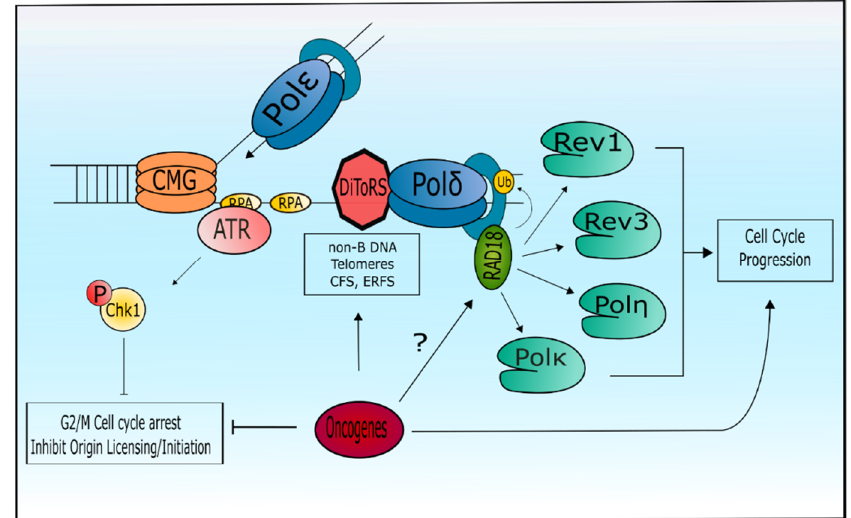
Figure 3. Conceptual framework for the role of specialized polymerases in oncogene induced replication stress. Oncogene activation promotes DNA replication thereby increasing replication fork encounters with DiToRS. Fork stalling activates the ATR/Chk1 axis and the subsequent recruitment of specialized DNA polymerase to resolve impediments. Rad18-mediated ubiquitination of PCNA is responsible, in part, for the recruitment of specialized DNA polymerase for distinct forms of DiToRS depending on the oncogenic cellular context. Engagement of specialized polymerases allows fork progression past DiToRS and continued cell cycle